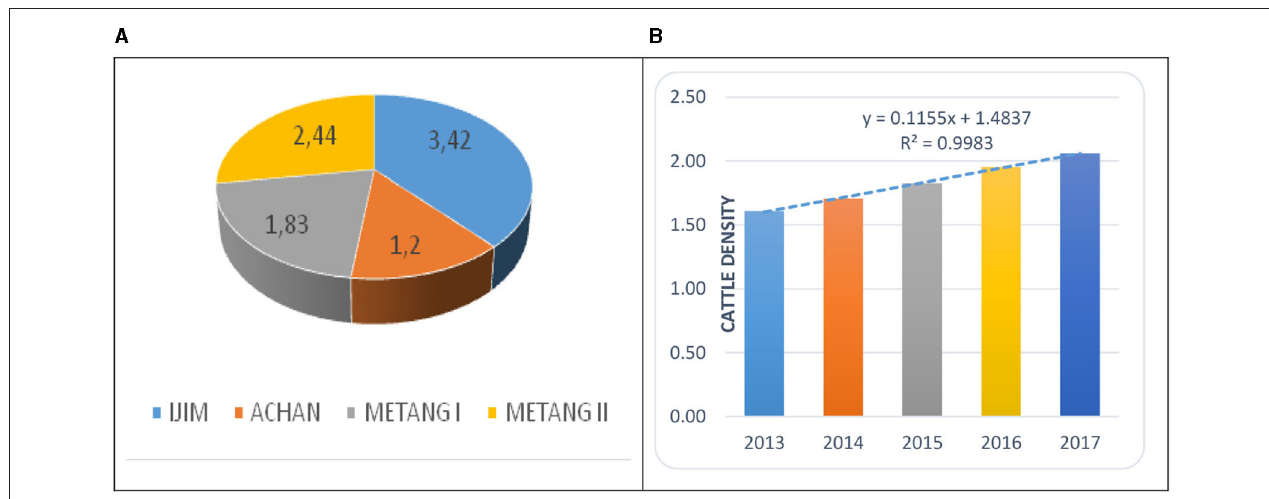
FIGURE 5 | Variation in carrying capacity in space and time. (A) Variation in carrying capacities within grazing zones. (B) Evolution in carrying capacities over the years for the entire zone. Source: Generated from data in Table 2 (2020).